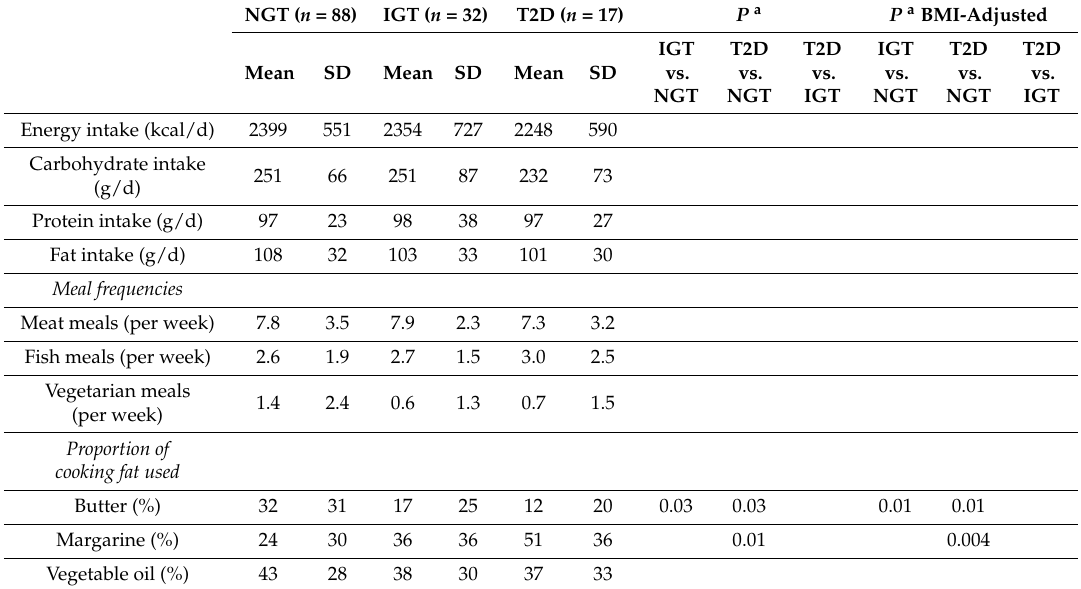
Table 2. Self-reported dietary intake of women 6 years after a GDM pregnancy. Women were divided into glucose tolerance groups based on OGTT at 6 year visit; type 2 diabetes (T2D) was determined by OGTT at time of diagnosis or at 6-year